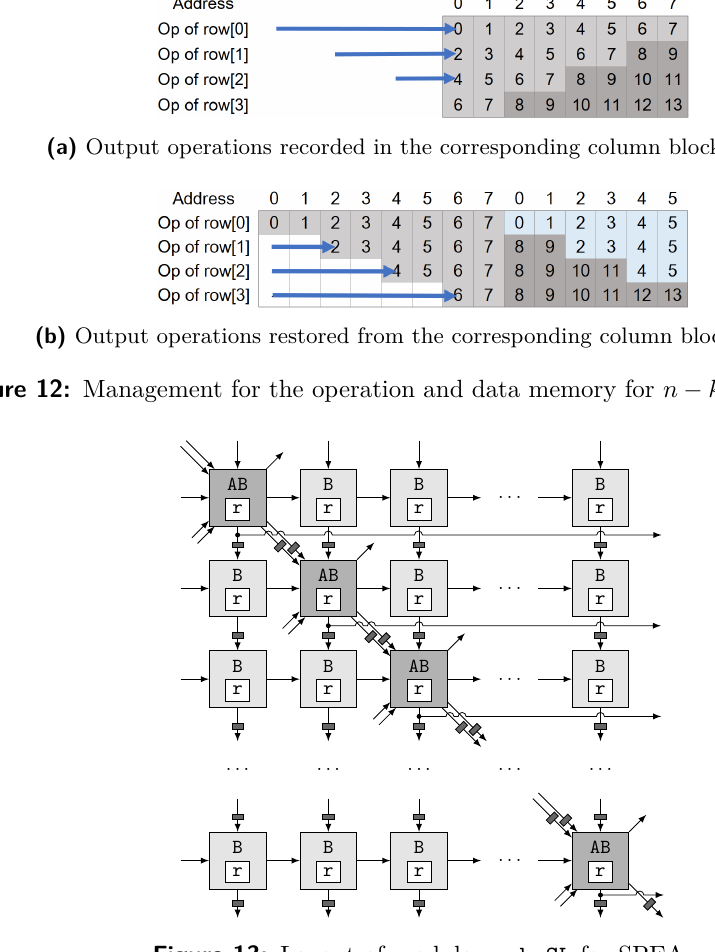
Figure 13: Layout of module comb_SL for